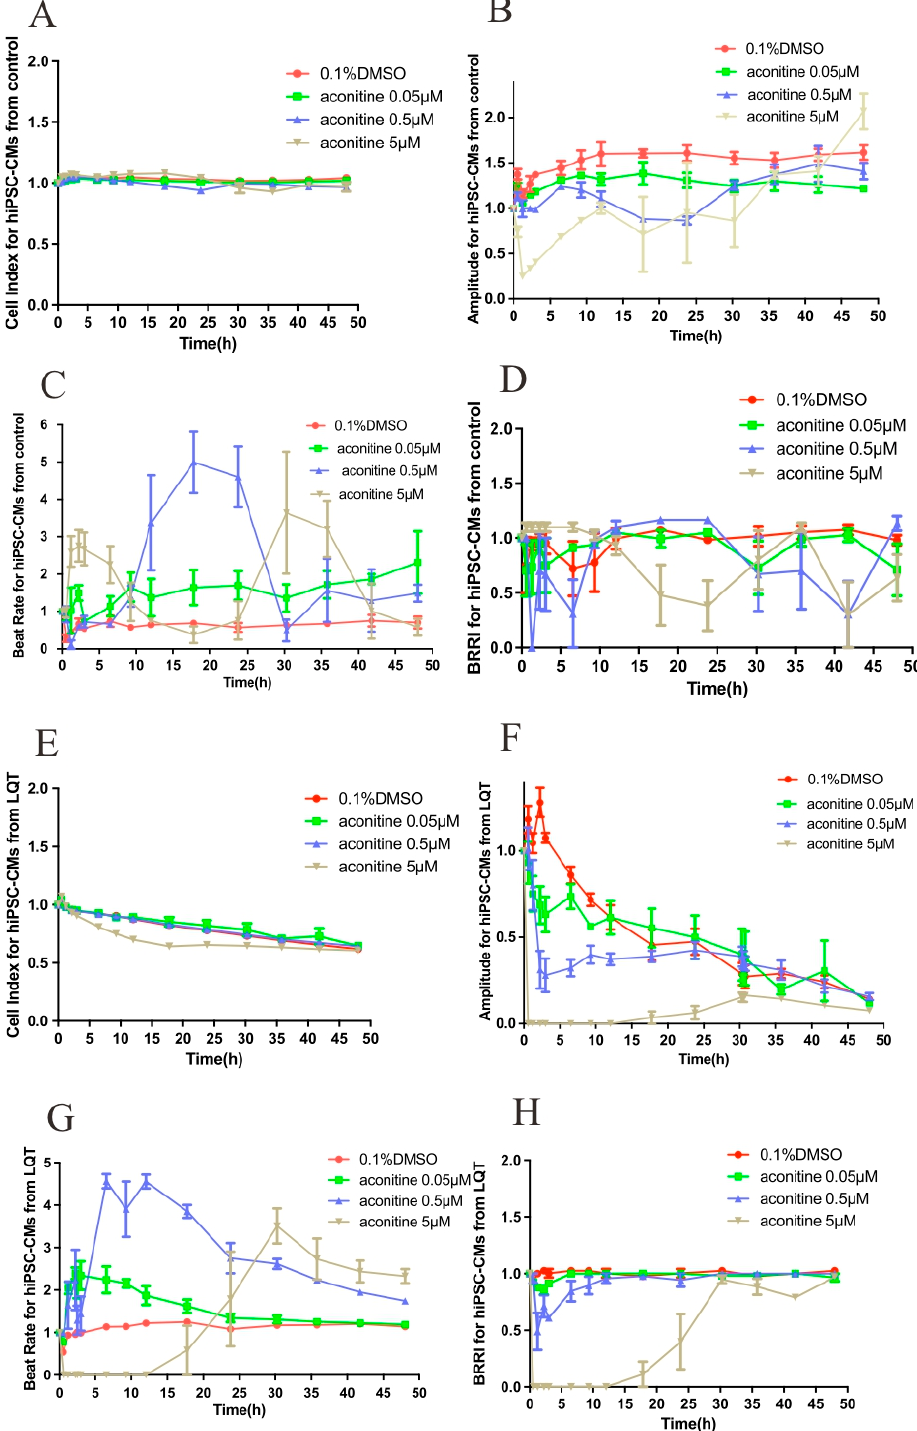
Figure 5. High-throughput analysis of AC toxicity in hiPSC-CMs from control or LQT syndrome. ( A ) Cell index of normal hiPSC-CMs exposed to AC; ( B ) Cell beat amplitude of normal hiPSC-CMs exposed to AC; ( C ) Cell beat frequency of normal hiPSC-CMs exposed to AC; ( D ) Cell beat rate of normal hiPSC-CMs exposed to AC; ( E ) Cell index of LQT syndrome hiPSC-CMs exposed to AC; ( F ) Cell beat amplitude of LQT syndrome hiPSC-CMs exposed to AC; ( G ) Cell beat frequency of LQT syndrome hiPSC-CMs exposed to AC; ( H ) Cell beat rate of LQT syndrome hiPSC-CMs exposed to AC. Cell contractility was significantly reduced at 5 μ M concentration and was very weak within 6 h after treatment. Cell beat rate of normal hiPSC-CMs exposed to AC (0.5 μ M) was faster after 12 h, while cell beat frequency of LQT syndrome hiPSC-CMs (AC 0.5 μ M) continued to 6 h. Effects of AC on LQT myocardial cells. None of the three concentrations caused sig- nificant myocardial cell death during the 48 h observation period. The concentration of 0.05 μ M had a significant effect on the cells, which showed higher contraction frequency and lower contraction force than the control group. The cell frequency and contractility were significantly increased at the 0.5 μ M concentration. The cell contractility decreased to zero with the 5 μ M concentration, and it was very weak within 30 h after treatment with AC. 2.4. Effects of AC on APD in Normal and LQT Syndrome hiPSC-CMs Figure 6 shows the whole-cell current-clamp recording from hiPSC-CMs and the ef- fects of AC on action potentials of hiPSC-CMs. Panel A shows an overlay of single action potentials from a representative cell from a control hiPSC-CMs and from a long-QT syn- drome (LQTS) hiPSC-CMs. It implied that AC (0.05, 0.5, and 5 μ M) concentration-de- pendently shortened APD50 at normal and LQTS hiPSC-CMs. The effects of AC resem- bled that of nifedipine, a specific LTCC blocker (Figure 7).